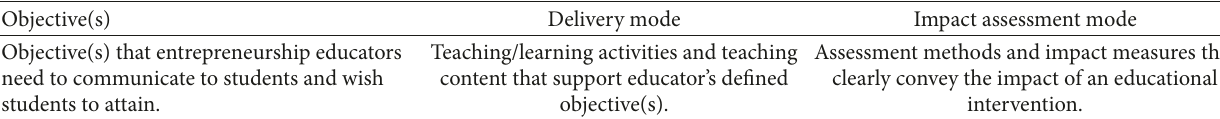
Table 2: Impact assessment